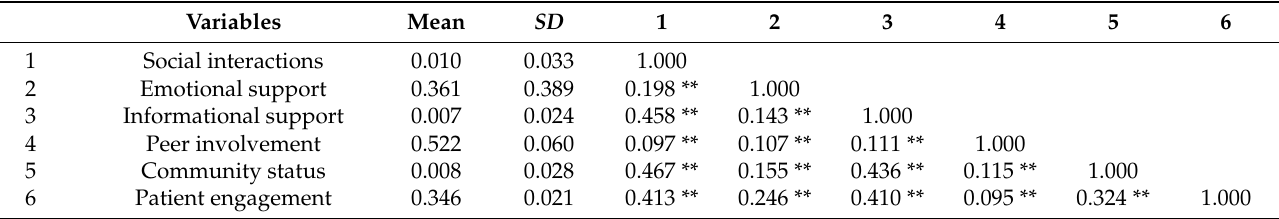
Table 2. Descriptive statistics and intercorrelations.